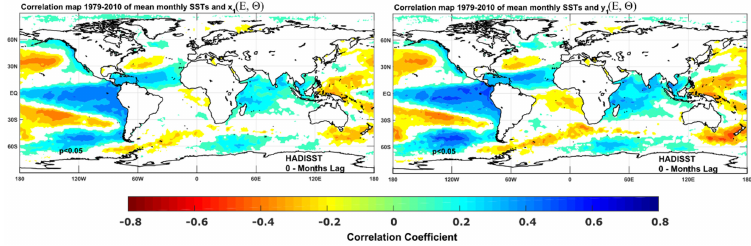
Figure 5. Maps of simultaneous correlations between SST anomalies and the time series associated with the leading MCA-mode between E( x ) and Θ ( y ).